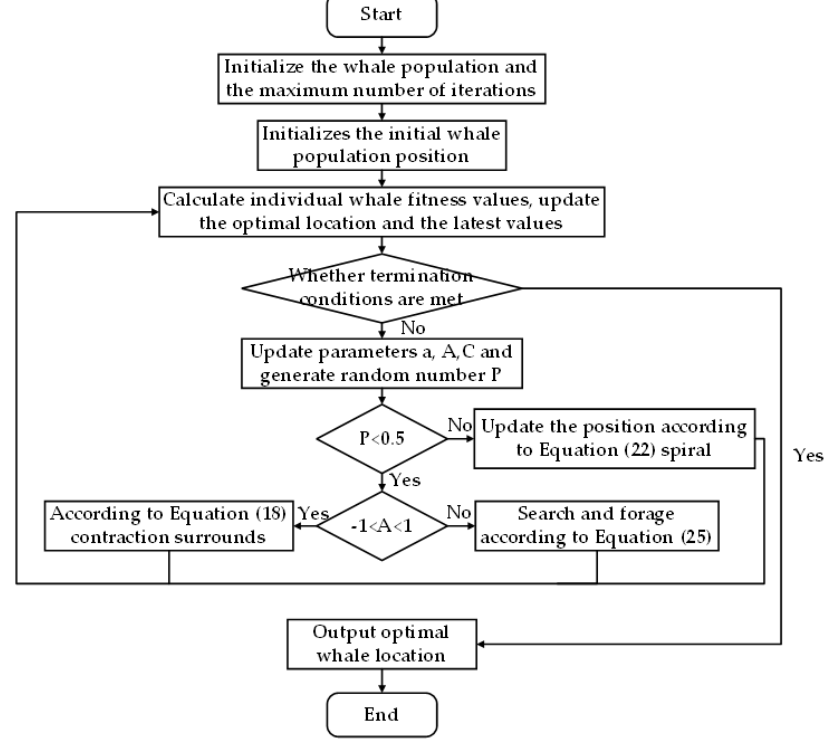
Figure 6. The whale optimization algorithm optimizes the process.